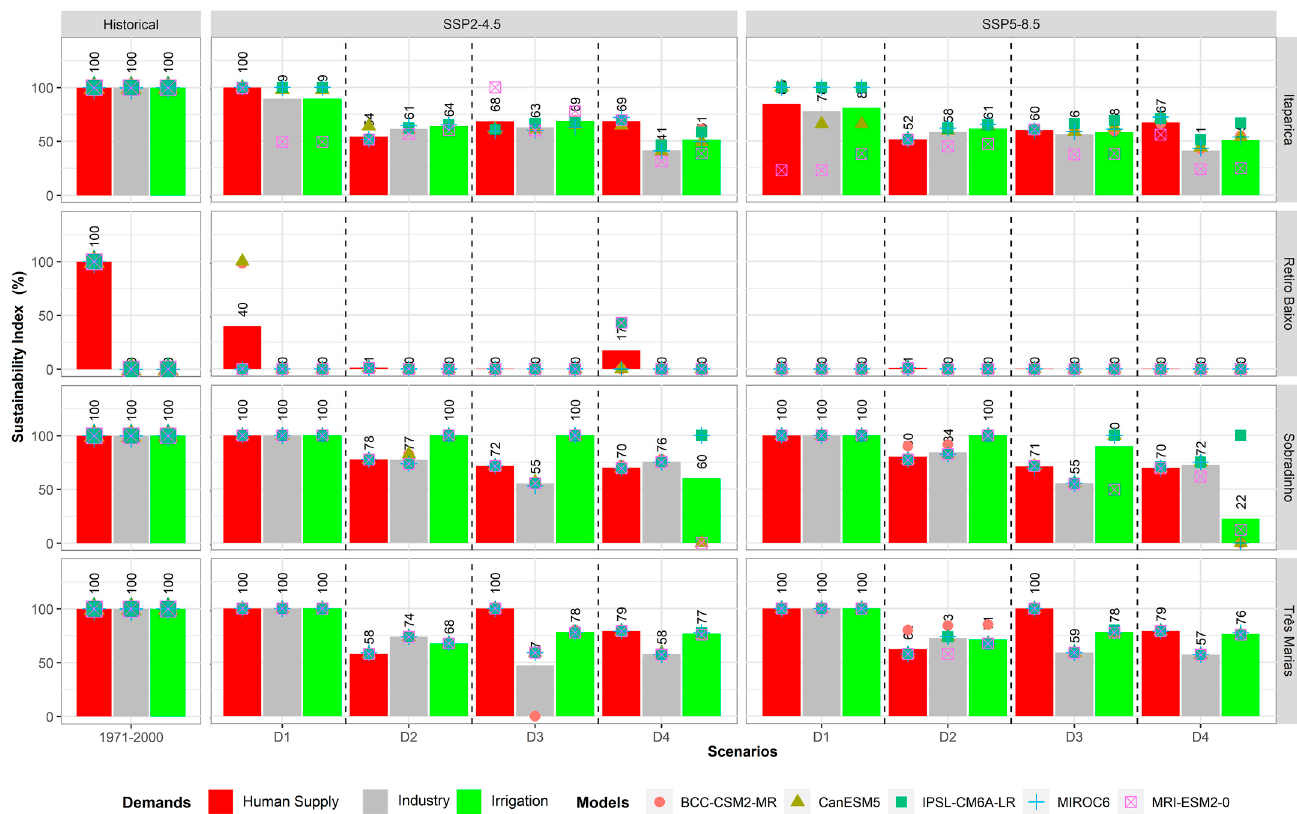
Figure 12. Sustainability Index of CMIP6 models for historical period (1971 to 2000), climate change scenarios (SSP2-4.5 and SSP5-8.5) and consumptive demands projection scenarios (D1, D2, D3 and D4) for SFRB reservoirs. The bars are the averages of the set of models.